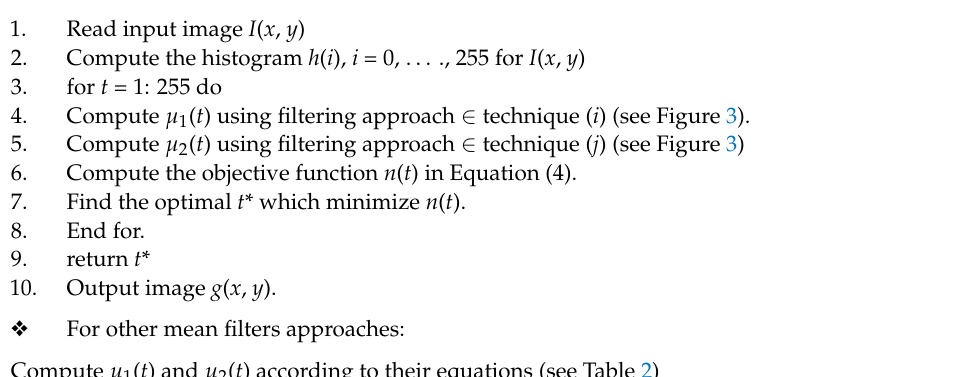
Algorithm 1 Single Input-Sequential Processing